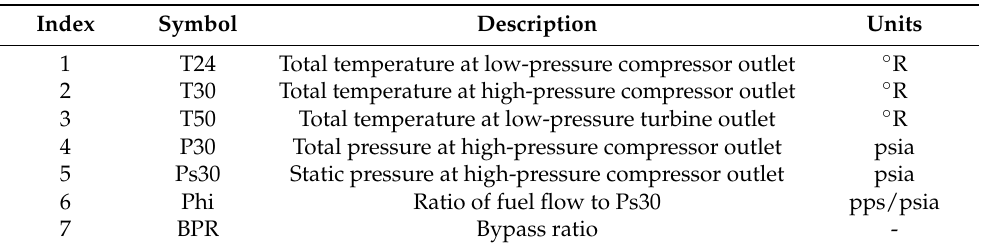
Table 2. Description of the selected sensor monitoring parameters for the construction of the synthesized degradation index (SDI).